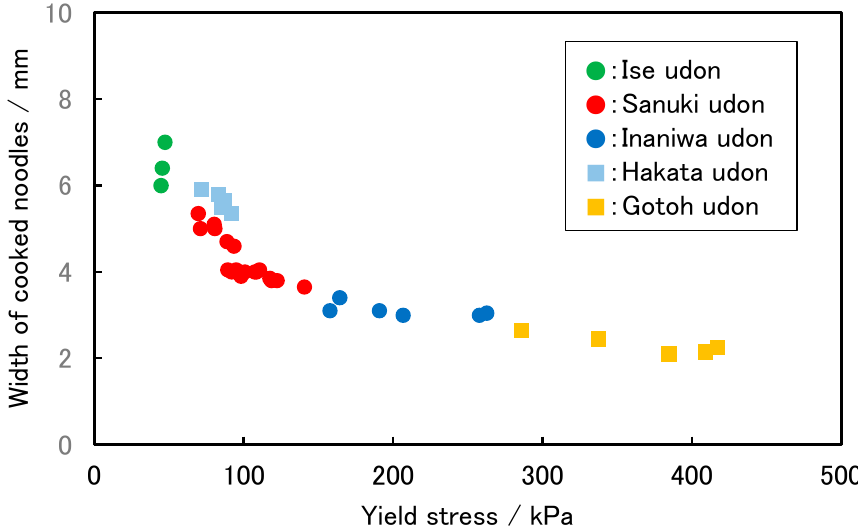
Figure 2. Relationship between the yield stress and width of udon noodles.